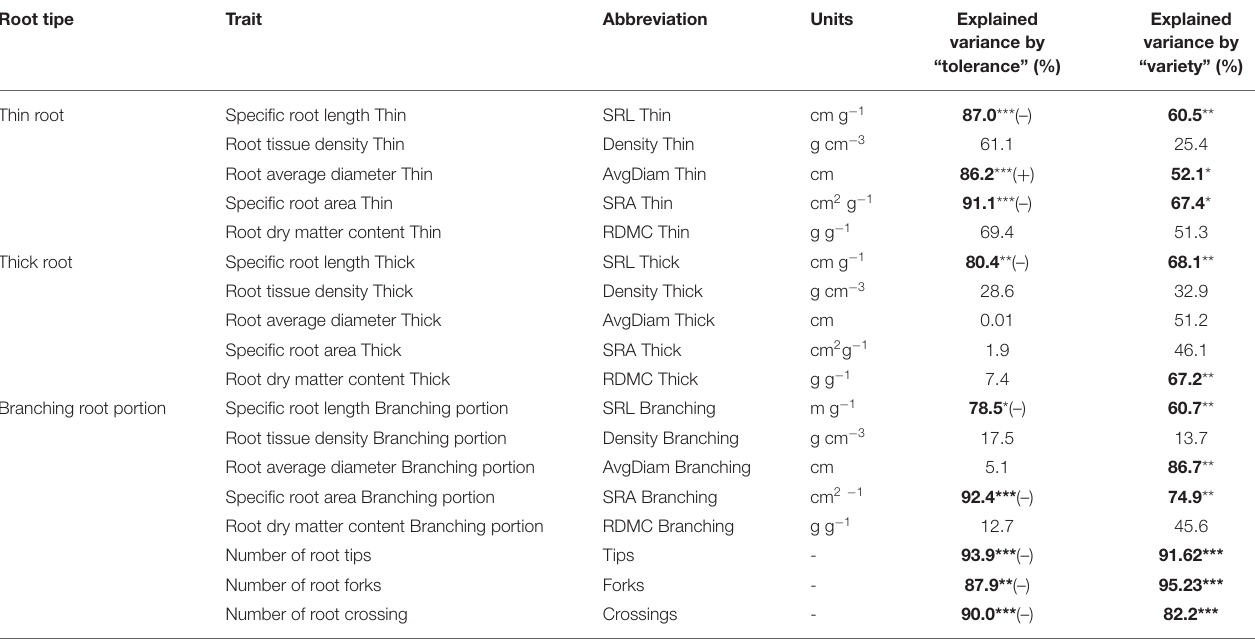
TABLE 1 | Results of ANOVA analyses for different root traits using the tolerance level to Verticillium wilt (“tolerance”) or olive variety (“variety”) as factors. Root tipe Trait Abbreviation Units Explained